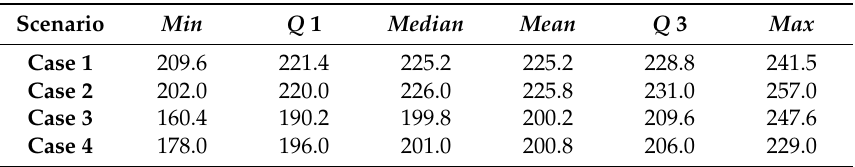
Table 1. Detailed statistics for sensor lifetime. Min is the smallest value in the sample. Max is the largest value in the sample. Mean is the sample mean. Median is the second quartile. Q 1 and Q 3 are the first and third quartiles.